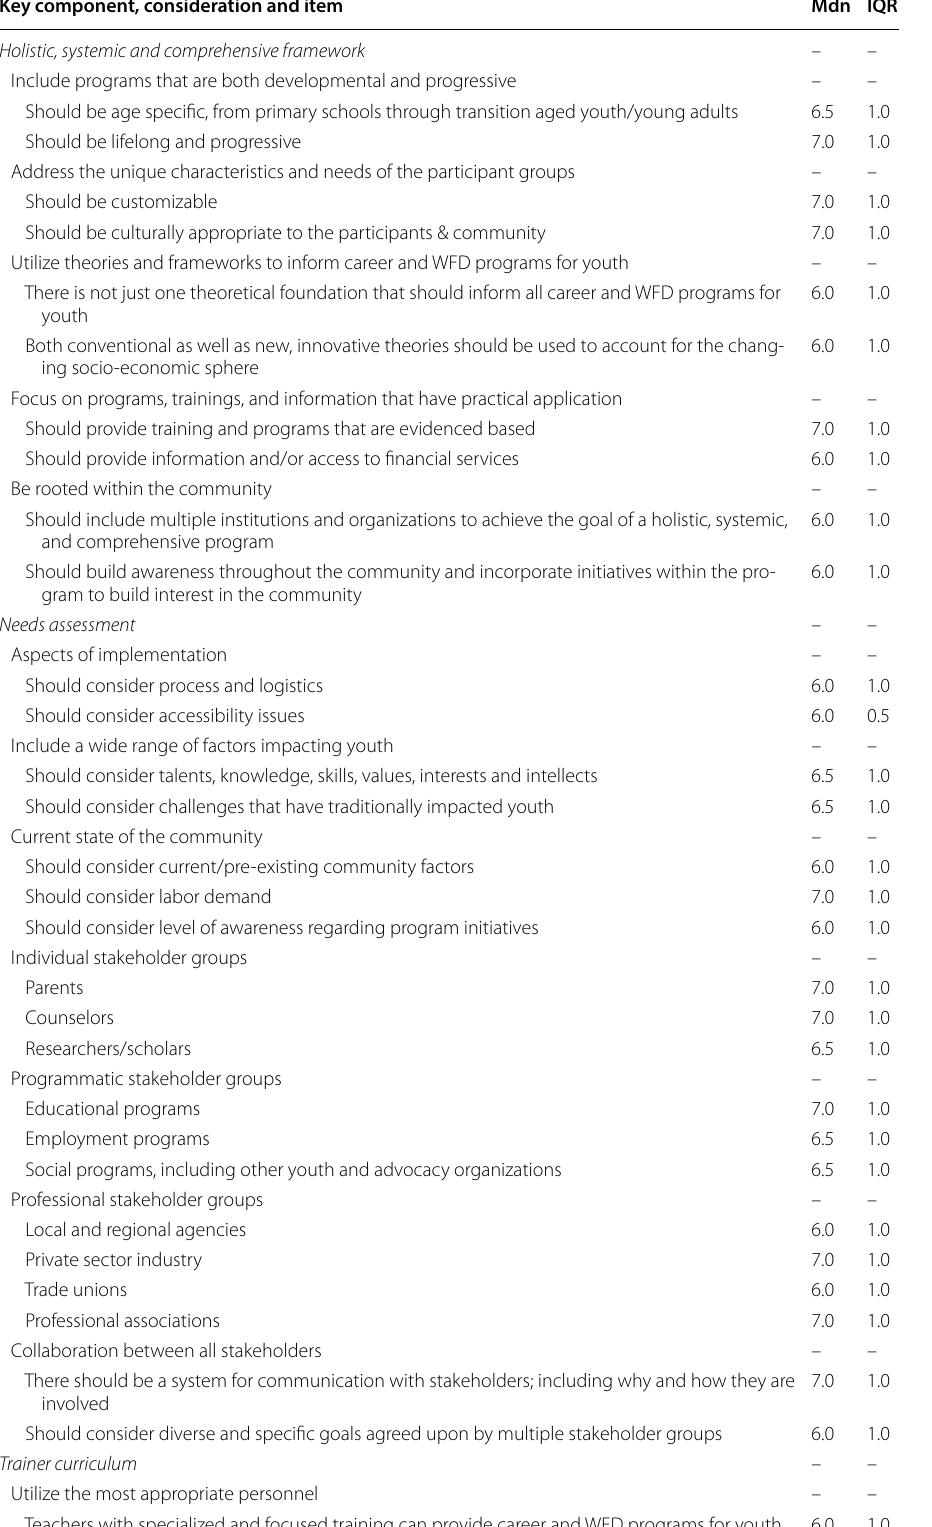
Table 2 Key components, considerations, and items (with Delphi scores) Key component, consideration and